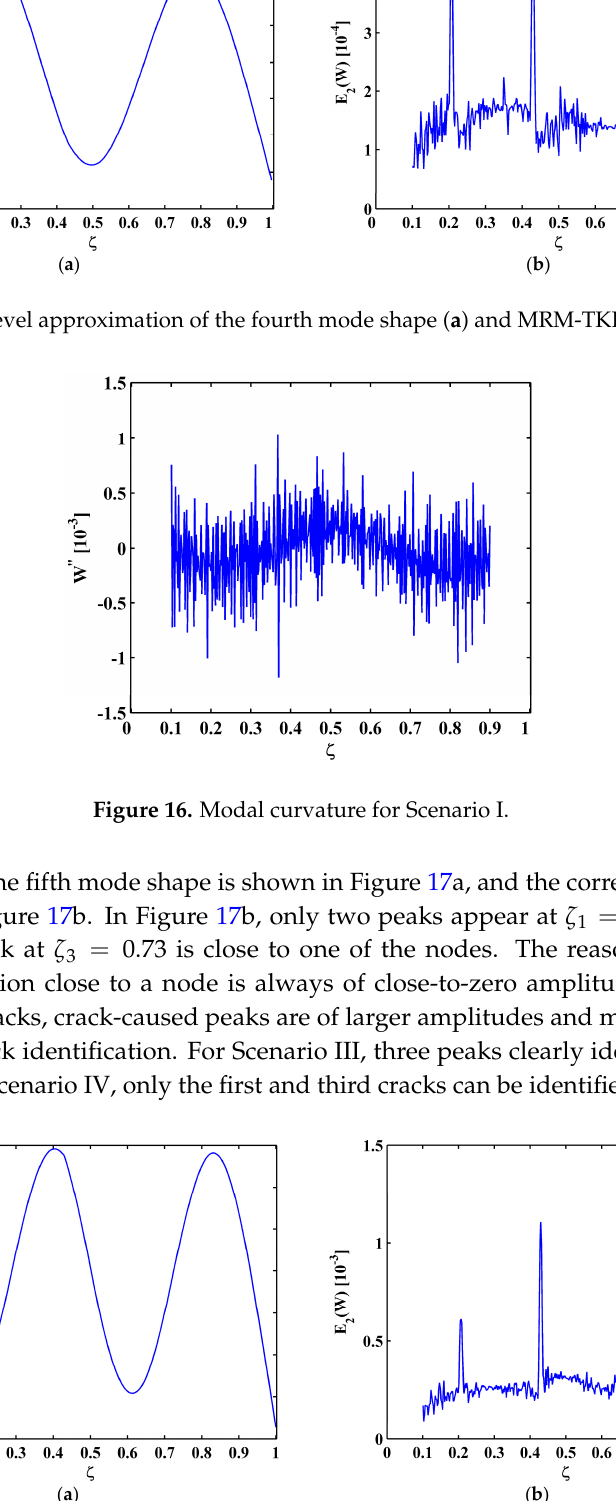
Figure 14. The fourth mode shape ( a ) and M-TKE ( b ) for Scenario I.